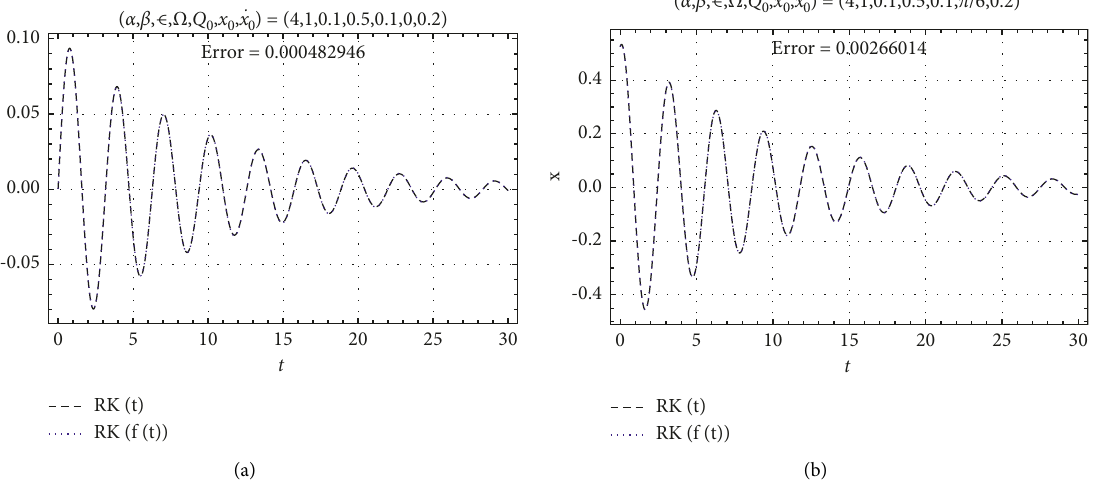
Figure 5: Both RK numerical simulation (32) and RK numerical simulation (33) using the definition of t Duffing–Mathieu problem (10) are compared with each other for different values to the initial amplitude x 0